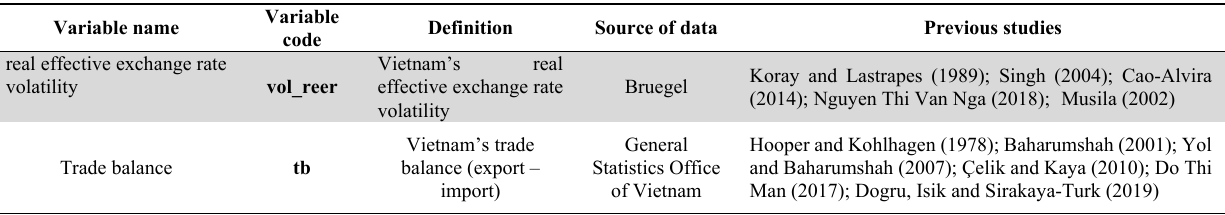
Source: The authors’